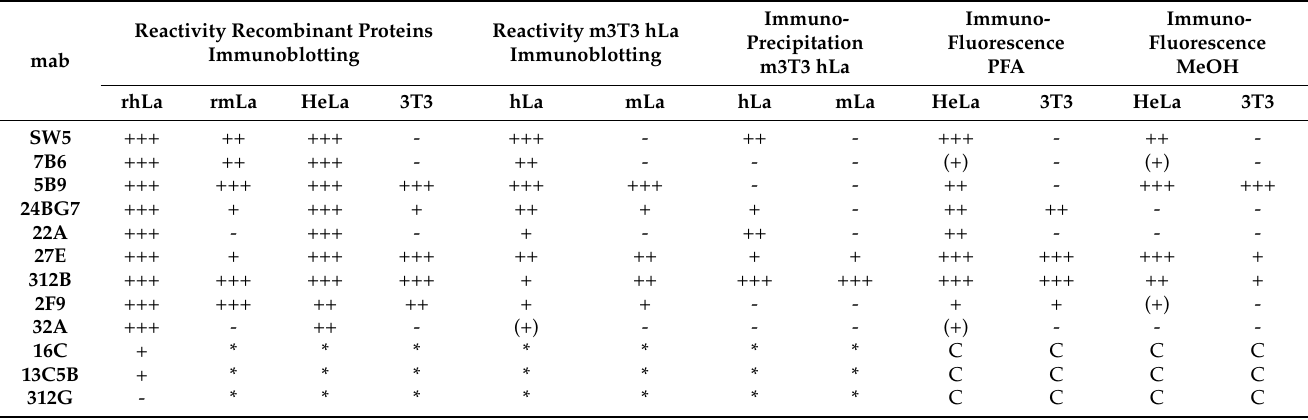
Table 4. Summary of reactivities of the mabs obtained by immunoblotting, coprecipitation, and epifluorescence microscopy. Semiquantitative evaluation of reactivities, (+++) strong, (++) medium, (+) low, ((+)) weak, (-) negative. C, cytoplasmic. (*) not